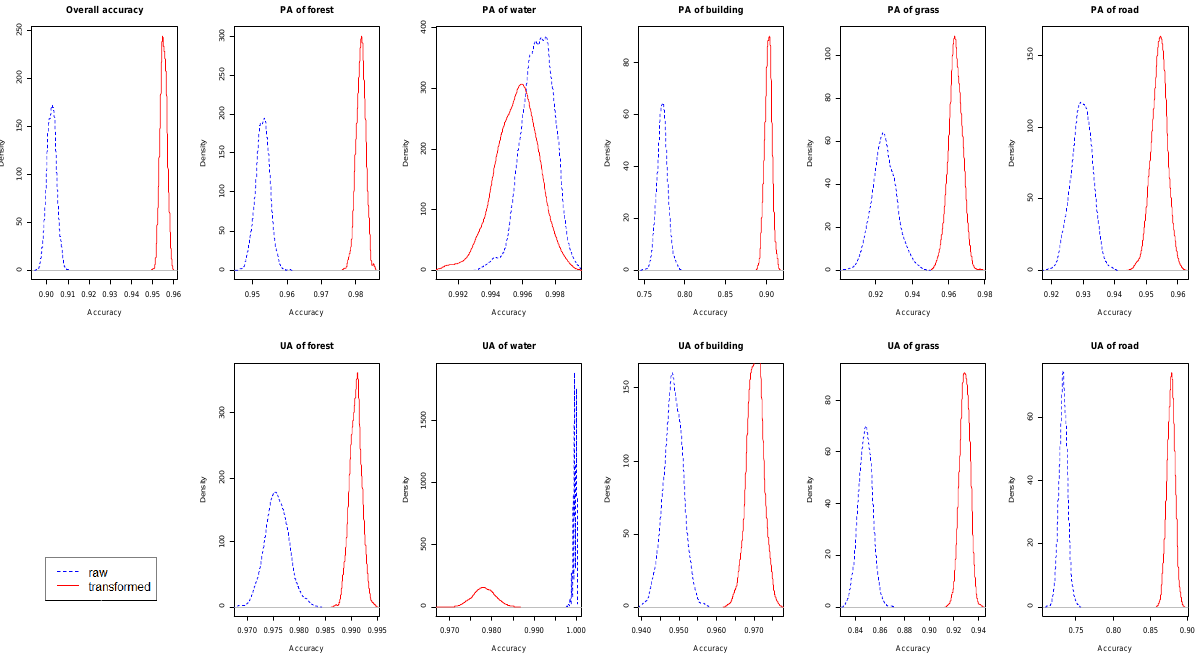
Figure 4. Comparison of classification results, including overall accuracy(OA), producer’s accuracies(PA), and user’s accuracies(UA) of individual class between original data and transformed